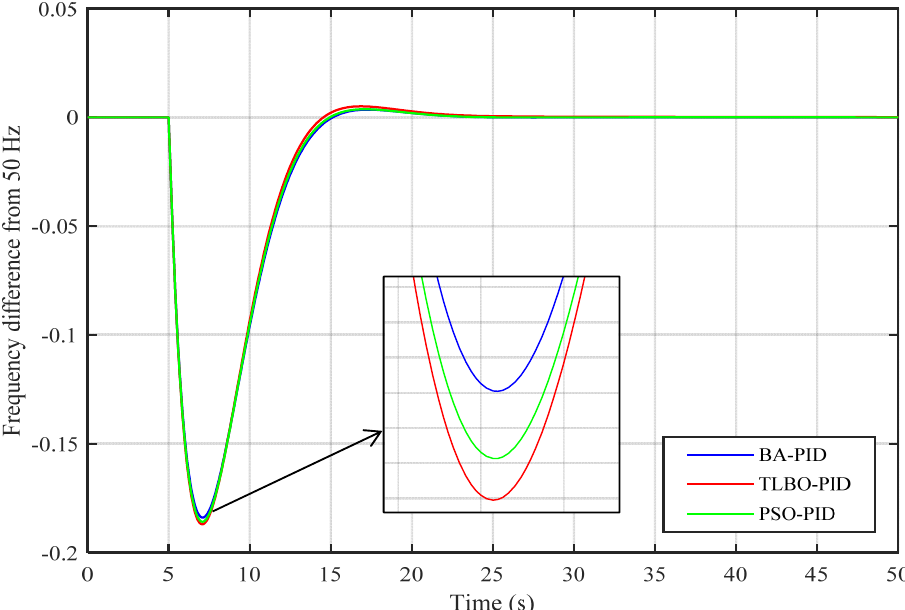
Figure 6. Change in frequency in the GB power system for 0.035 pu load disturbance with tuned PID-based ISE. Table 8. Frequency response performances with PID tuned by different algorithms and designed by minimizing ITAE.